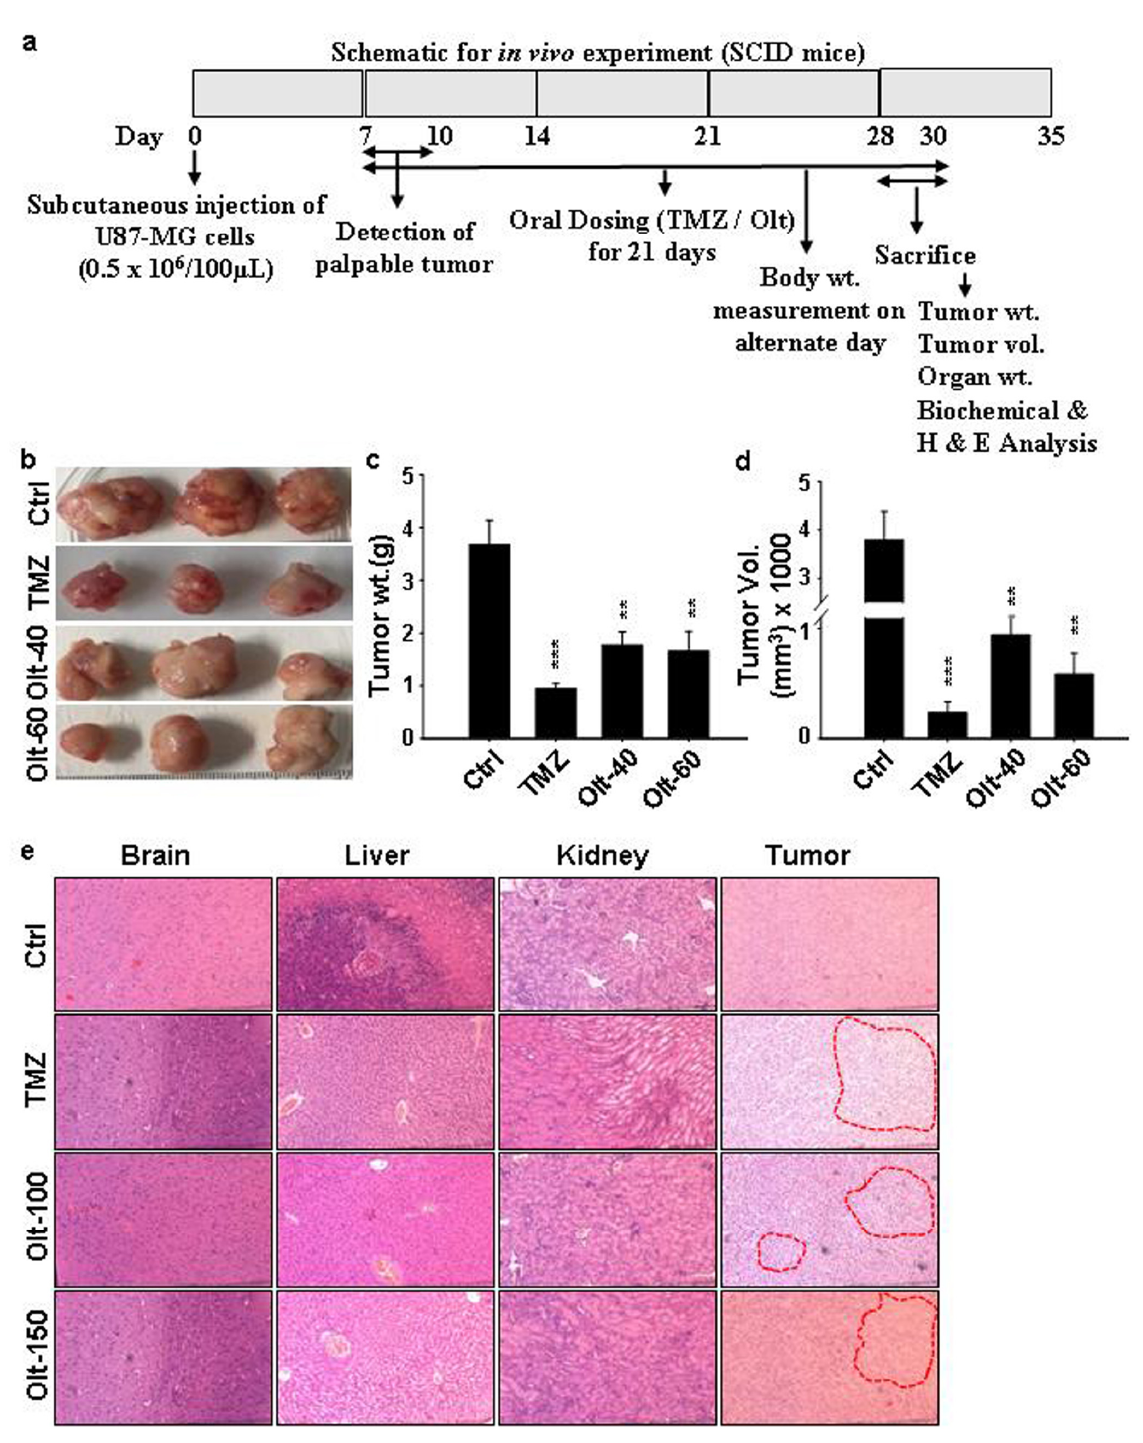
Figure 6. Anti-tumorigenic efficacy of Olt in vivo. TMZ (positive control) and Olt administration for 3 w, at the stated doses, led to reduced tumor progression in the U-87 MG cell-induced GBM xenograft mouse model. ( a ) The schematic for in vivo experiment. ( b ) Representative images of tumors excised from different groups (n = 5/group). ( c,d ) Measurement of tumor weight ( c ) and volume ( d ) in each group post-sacrifice. Data are presented as mean ± SEM ** p ≤ 0.01, *** p ≤ 0.001 compared to the disease control (Ctrl) group. ( e ) Representative images of H&E-stained tissue sections taken from tumor and stated vital organs from disease control (Ctrl) and U-87 MG cell-induced GBM tumor-bearing